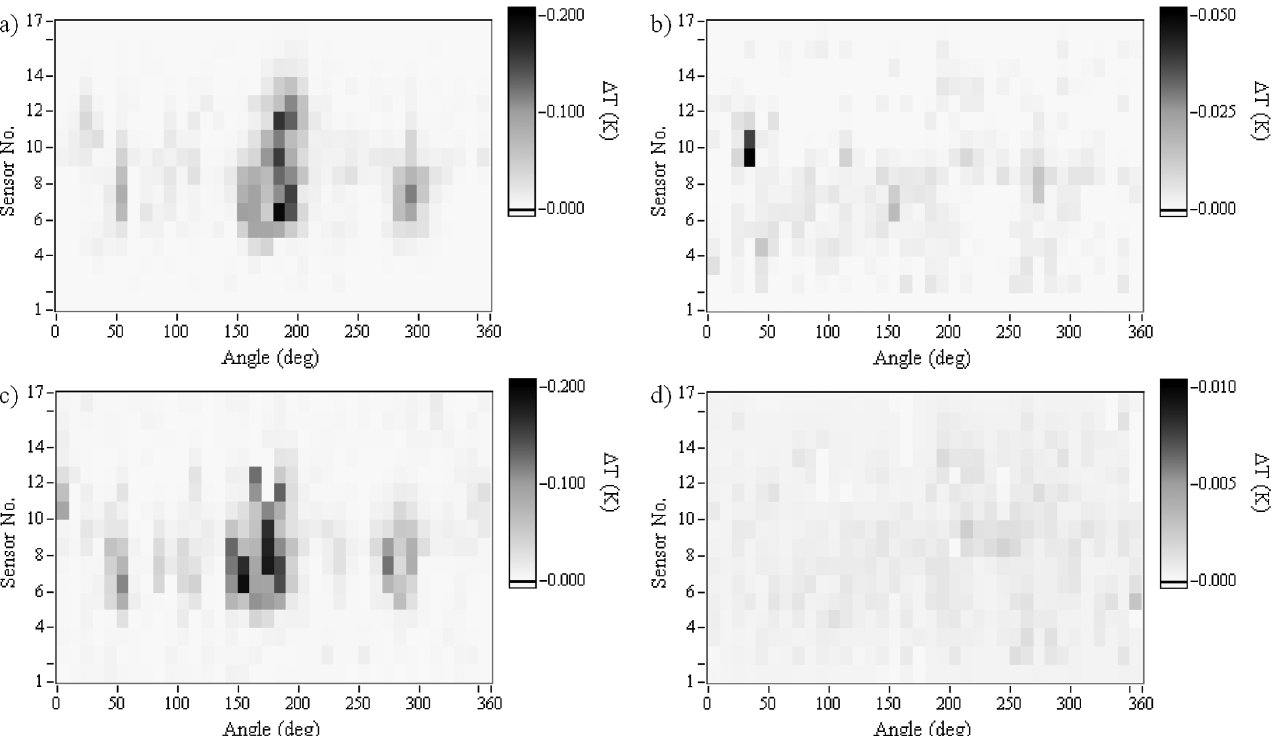
FIG. 15. Unfolded temperature maps at 2.0 K at the highest field achieved in the high-power rf tests of a large-grain CEBAF single- cell cavity after baseline tests 2 (a) and 3 (c) and after heat treatments 2 (b) and 3 (d). Note the different (cid:2) T scales. Large hot spots present in the baseline tests are greatly reduced after heat treatments. Sensors No. 1 and 16 are located at the top and bottom iris of the cavity, respectively, while the equator weld is between sensors No. 8 and No.